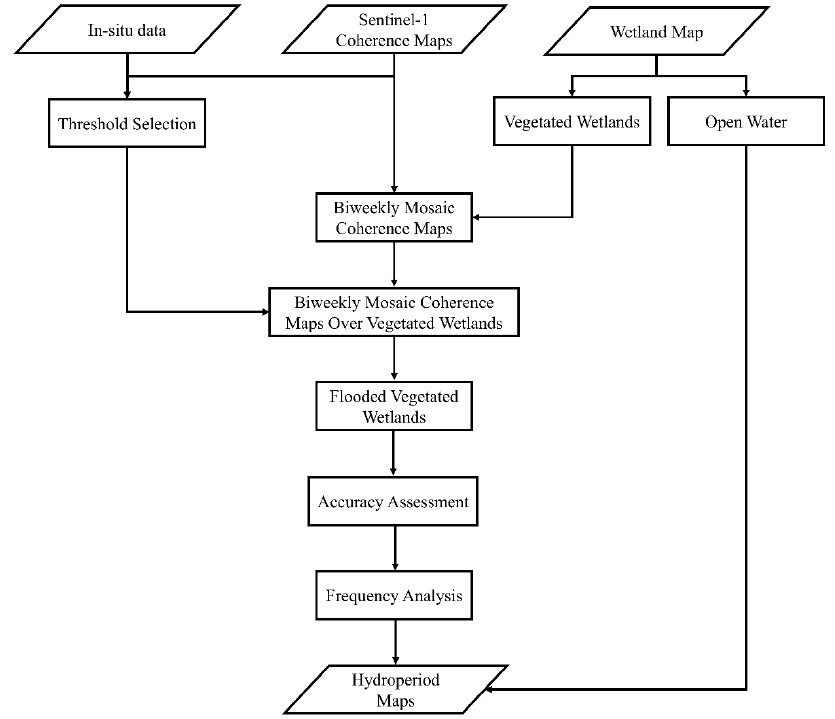
Figure 3. Flowchart of the method for analyzing the wetland hydroperiod using the InSAR coher- ence products.